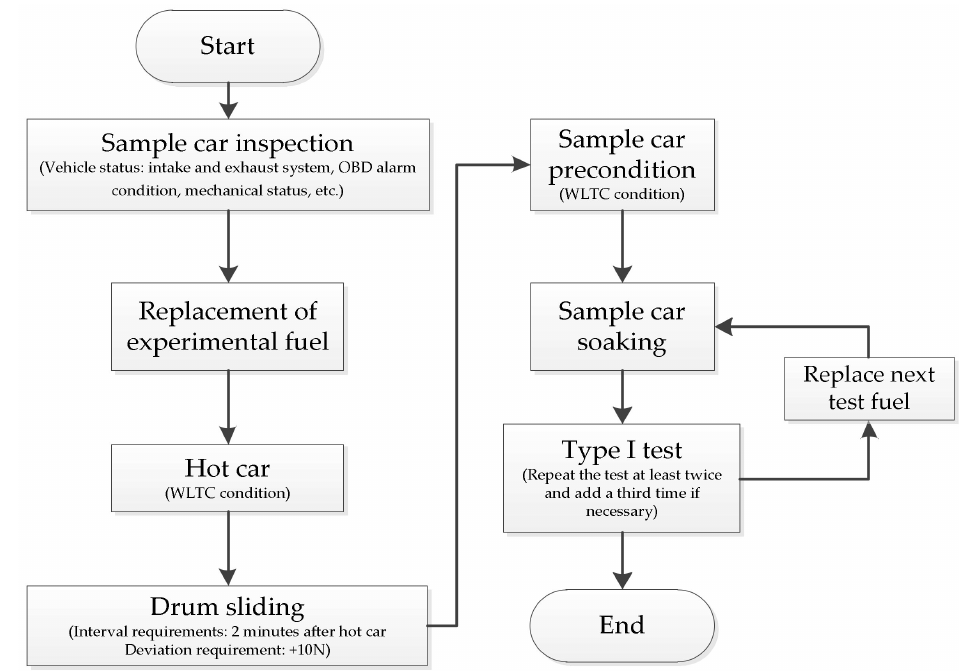
Figure 2. Flowchart for the test procedure.